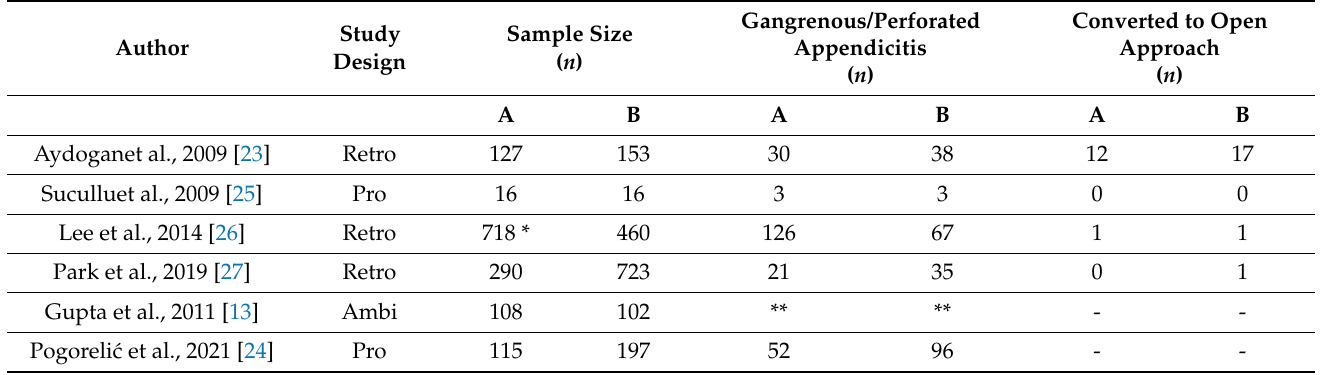
Figure 1. Selection of the relevant studies using the Preferred Reporting Items for Systematic Review and Meta-Analysis (PRISMA) flow diagram. Table 1. Baseline characteristics of the included studies. * includes 372 and 246 patients in whom Harmonic scalpel and monopolar cautery were, respectively, utilized.